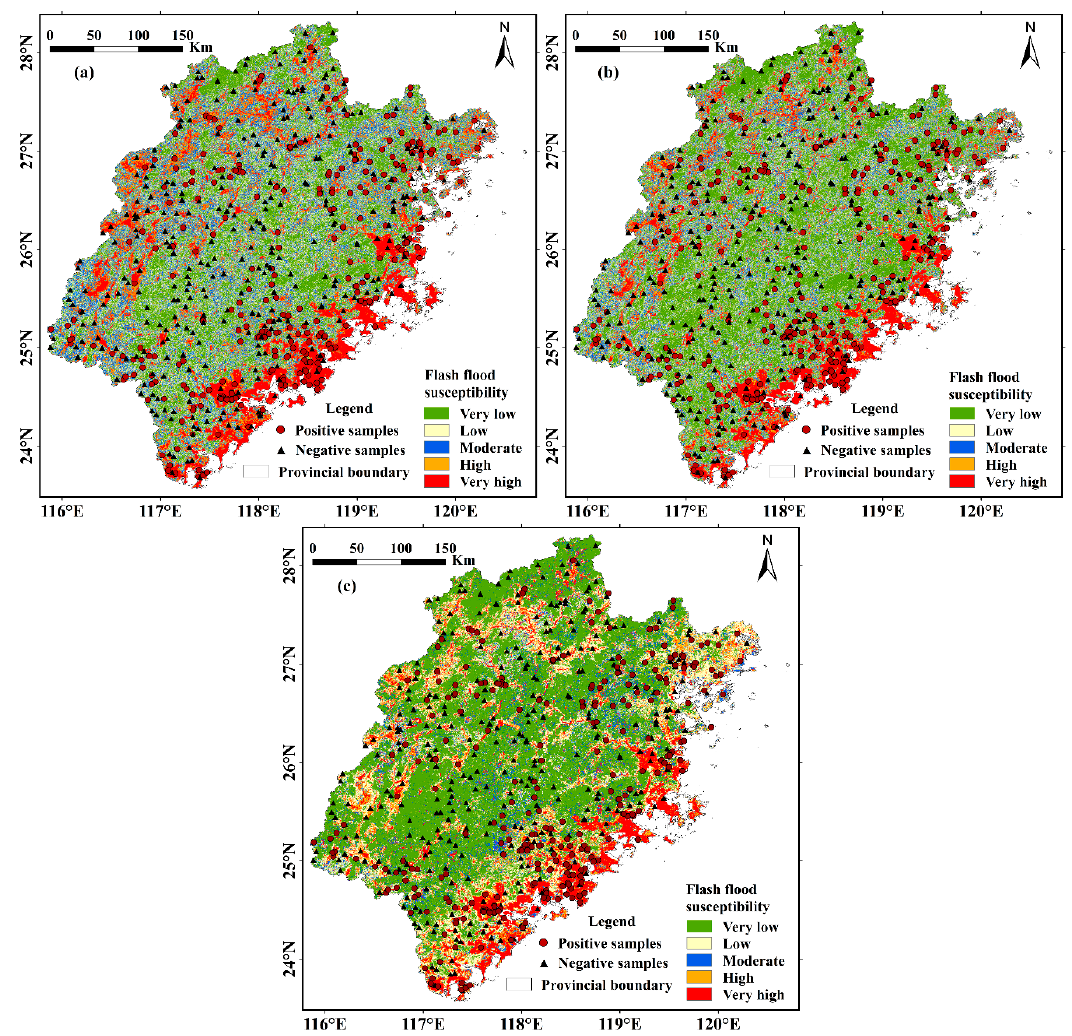
Figure 4. Flash flood susceptibility map produced using the ( a ) CF, ( b ) LR, and ( c ) CF-LR models.